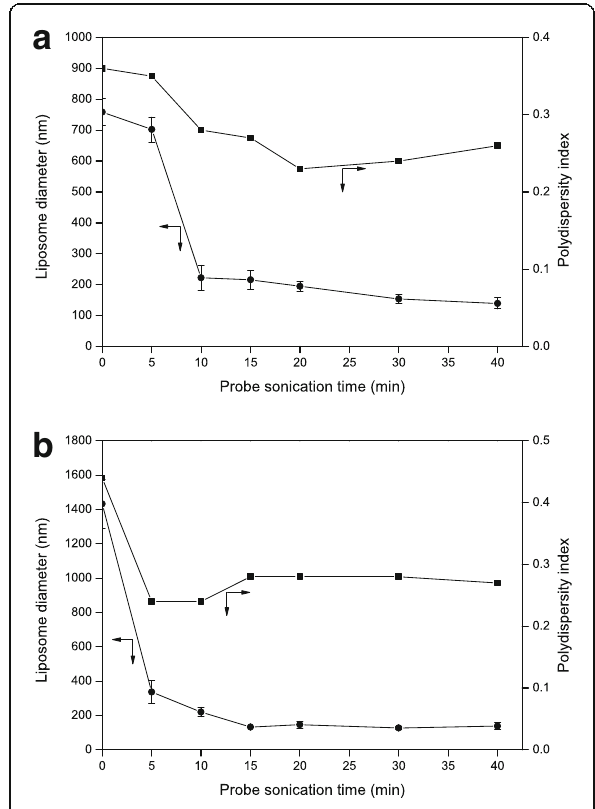
Fig. 2 Effects of probe sonication time on diameter and polydispersity index of ERL-encapsulated nanoliposomes: an ice-water bath ( a ) or a water bath ( b ) cooling of liposome suspension in a container during ultrasonication ( n =3, the data are presented as